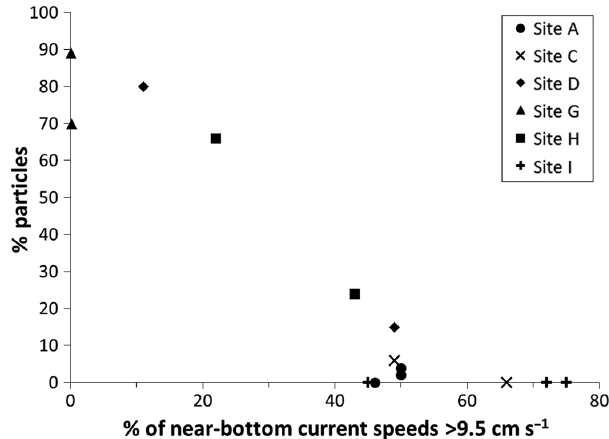
Fig. 2. Percentage of model particles remaining within the 1 × 1 km model domain when DEPOMOD was run with resus- pension vs. the percentage of near-bottom current speeds ex- ceeding the threshold for resuspension (>9.5 cm s −1 ). When DEPOMOD was run without resuspension, all particles re- mained within the model domain at all sites. The re sults shown are for model runs using average daily feeding rates during 1 mo periods including the date of sediment